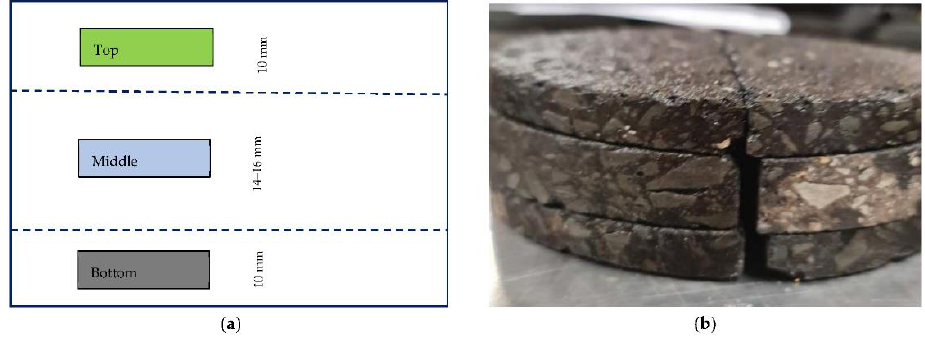
Figure 1. Core cutting plan ( a ) schematic and ( b )